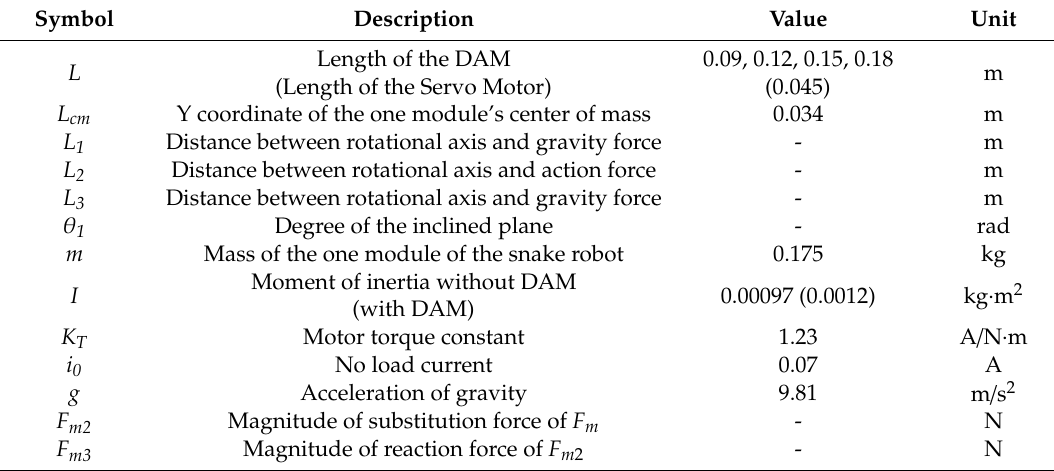
Table 1. Parameters for dynamic